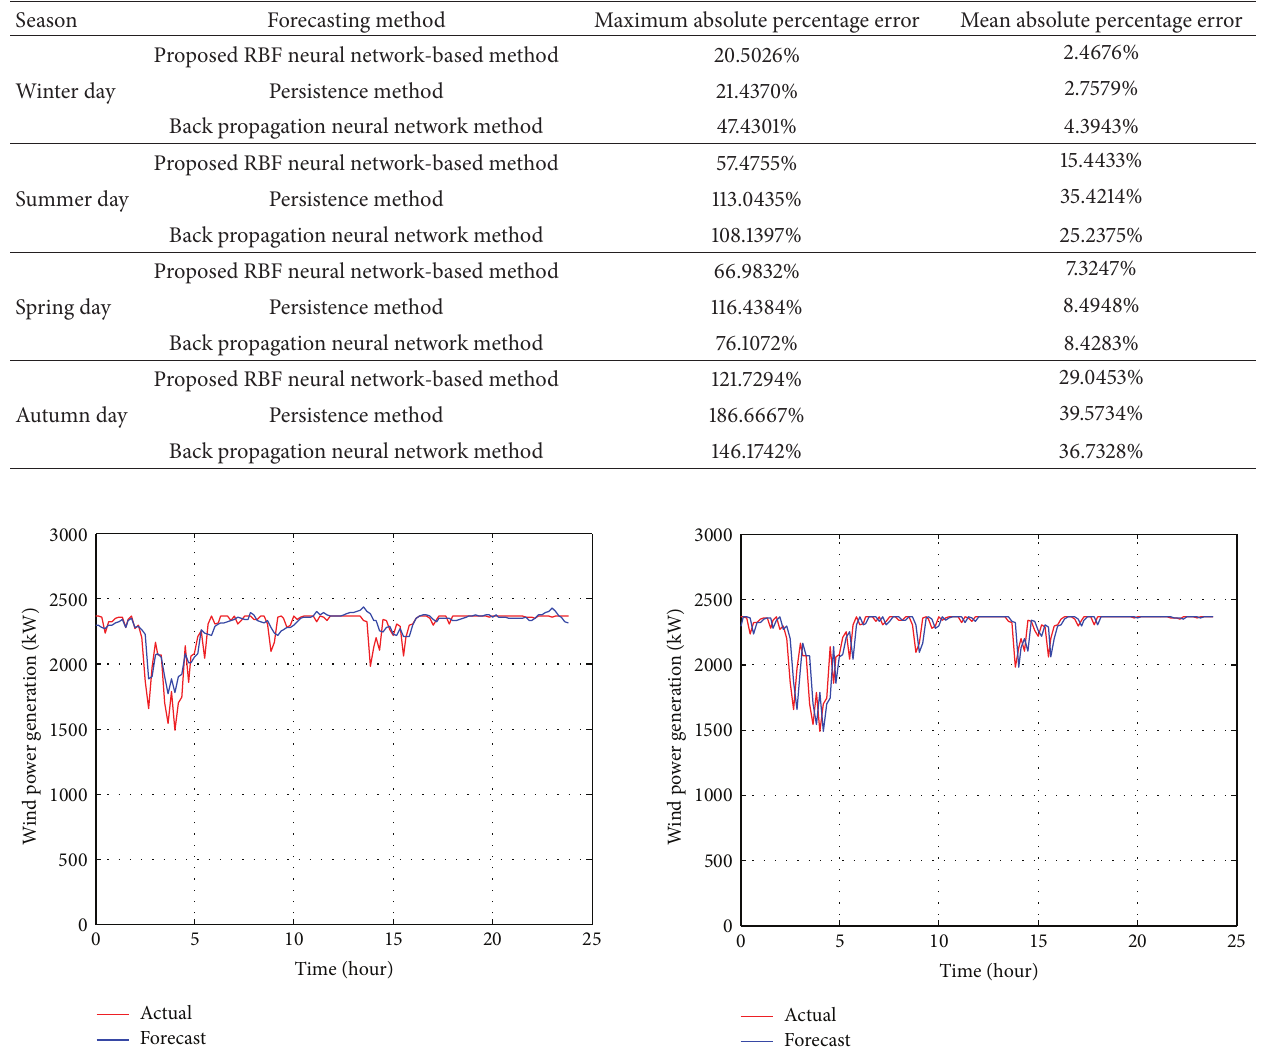
Table 1: The evaluation of the accuracy of the three methods in wind power forecasting.